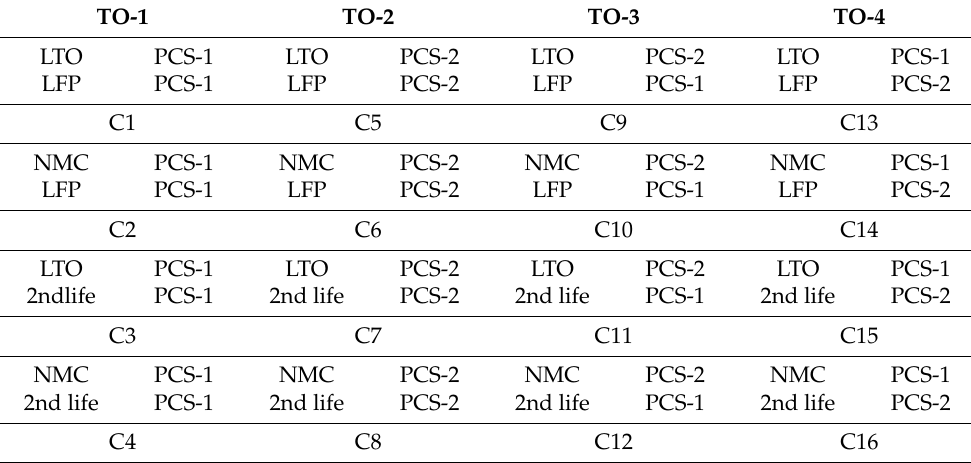
Table 5. Combination among the cells and PCS configurations for global optimum selection and sizing of HBESS